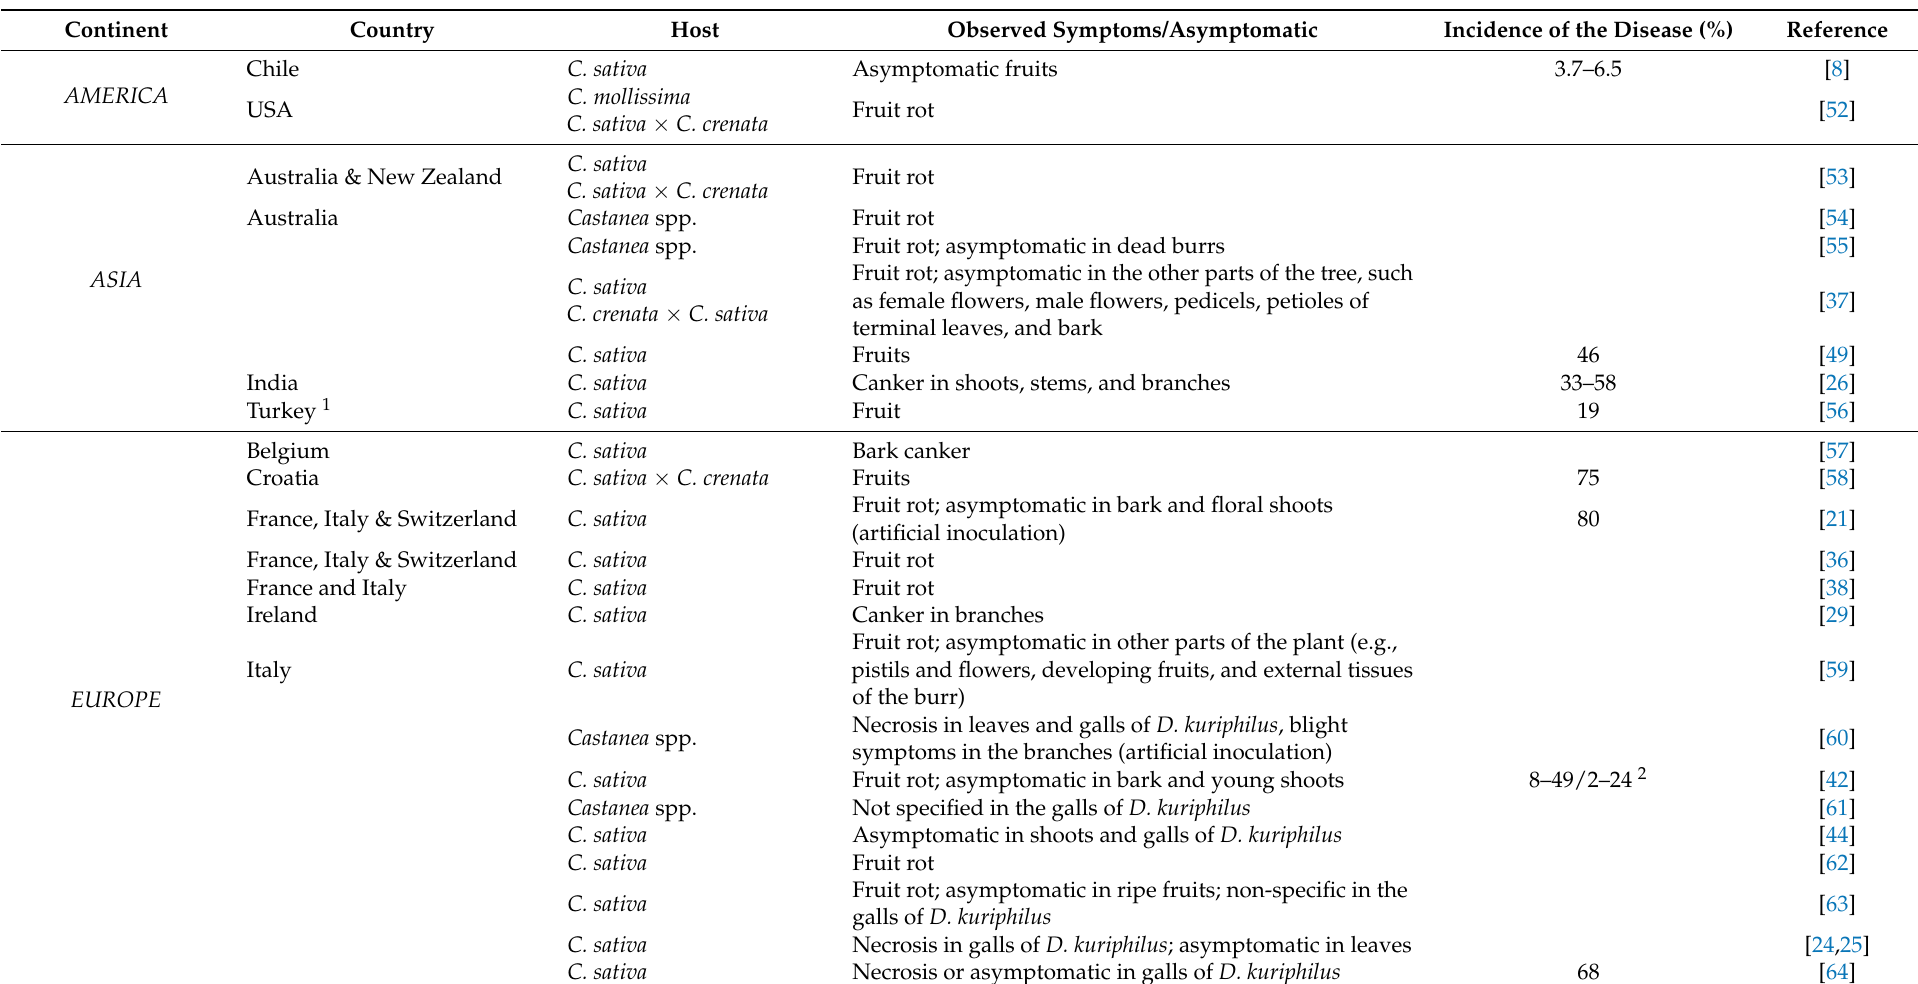
Table 2. Host of G. smithogilvyi in several species of Castanea , observed symptoms/asymptomatic, and incidence of the disease (%) (Source: Adapted from Lione et al. [22] and